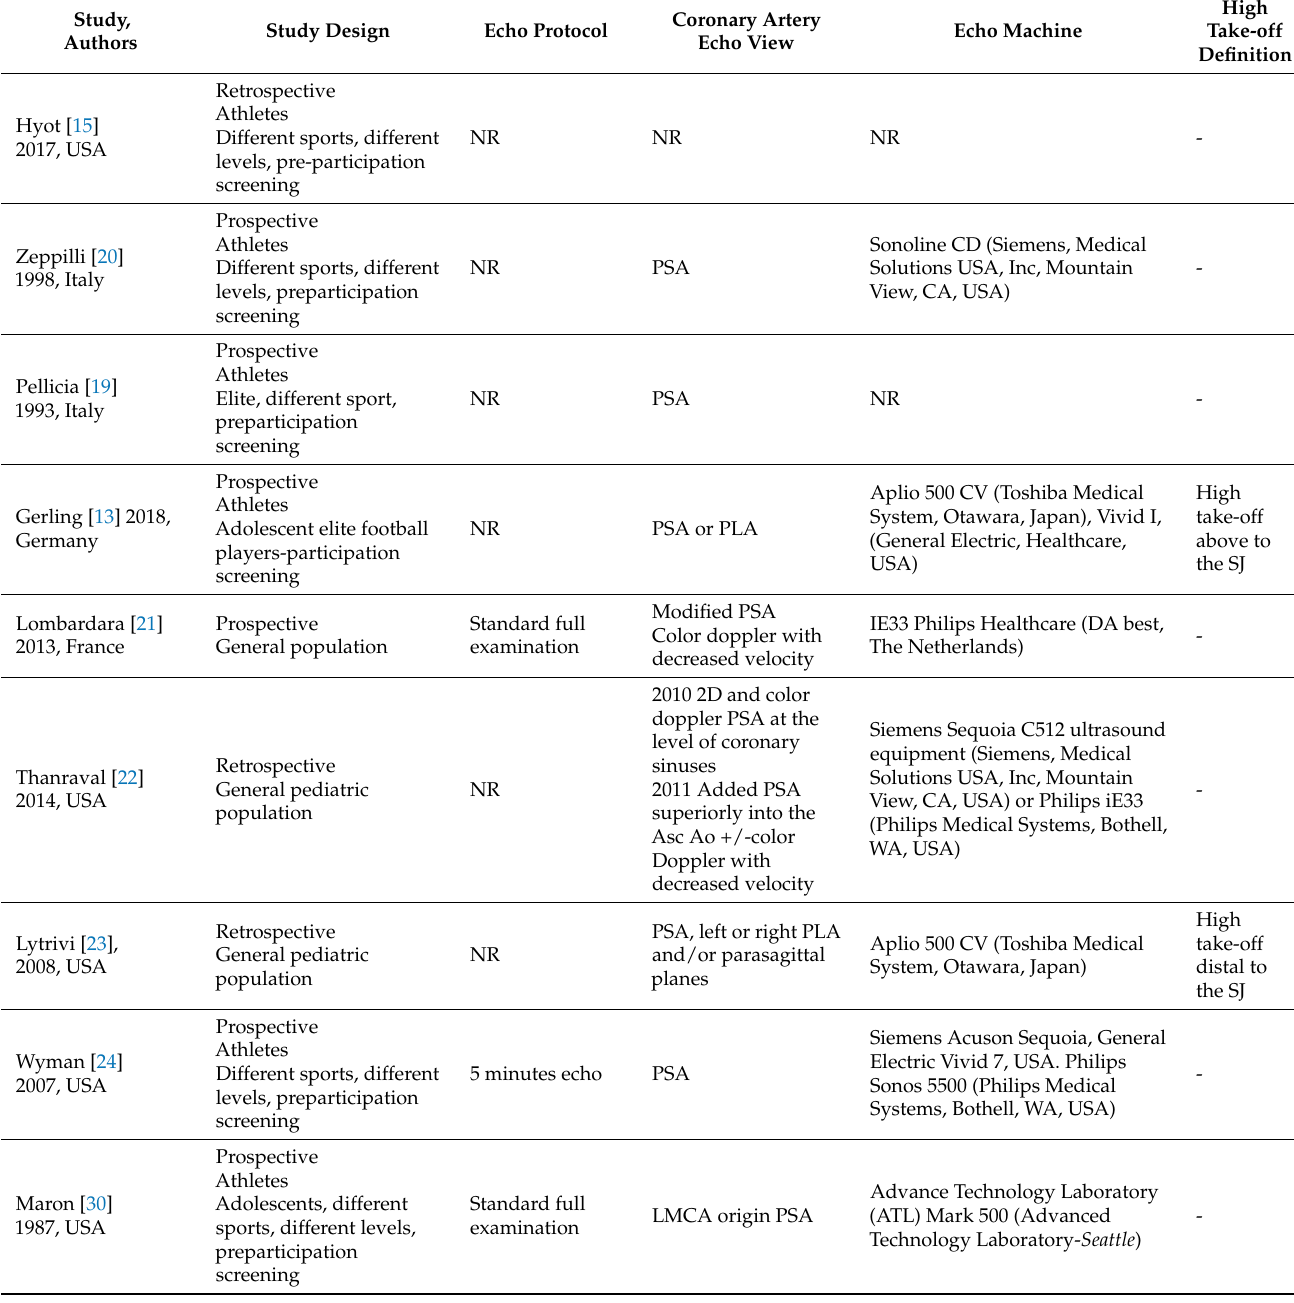
Table 1. Methodology of studies who systematically screened coronary artery origin by